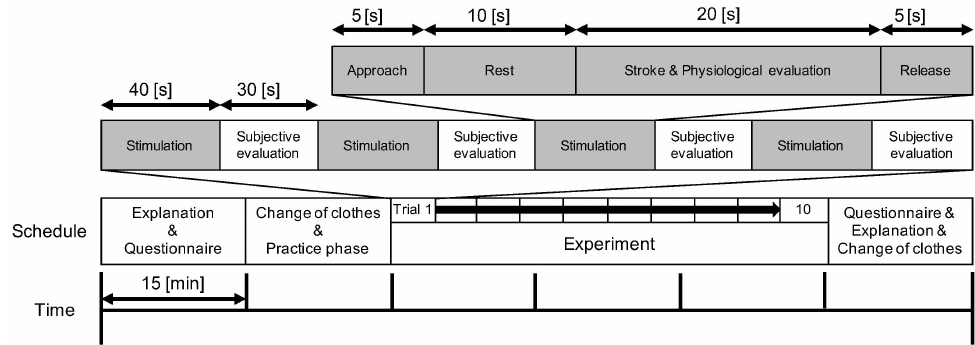
Figure 6. The experimental